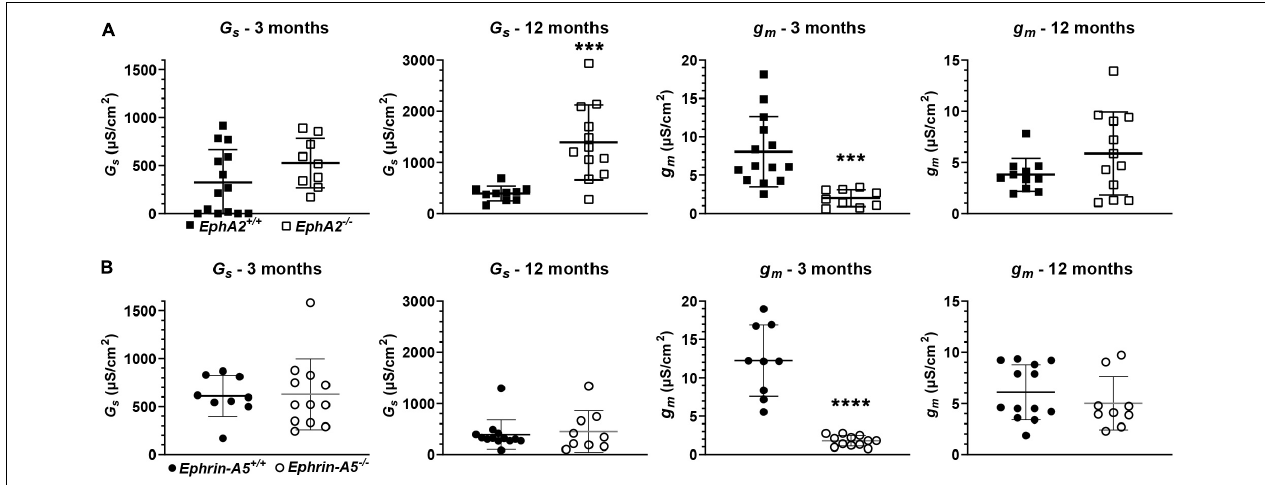
FIGURE 9 | Surface conductance ( G S ) and mature fiber conductance ( g m ) in lenses from 3- and 12-month-old control, EphA2 − / − and ephrin-A5 − / − mice. (A) Mean and standard deviation of G S and g m in lenses from 3- or 12-month-old EphA2 + / + (black squares) and EphA2 − / − (open squares) mice. While G S is comparable between lenses from young control and KO mice, G S is elevated in lenses from 12-month-old EphA2 − / − mice. g m is decreased in lenses from 3-month-old EphA2 − / − mice. (B) Mean and standard deviation of G S and g m in lenses from 3- or 12-month-old ephrin-A5 + / + (black circles) and ephrin-A5 − / − (open circles) mice. There is no obvious change in G S in lenses from KO mice at either age or g m in lenses from young KO mice. However, g m is decreased in lenses from 12-month-old ephrin-A5 − / − mice. ***, p < 0.001; ****, p < 0.0001.